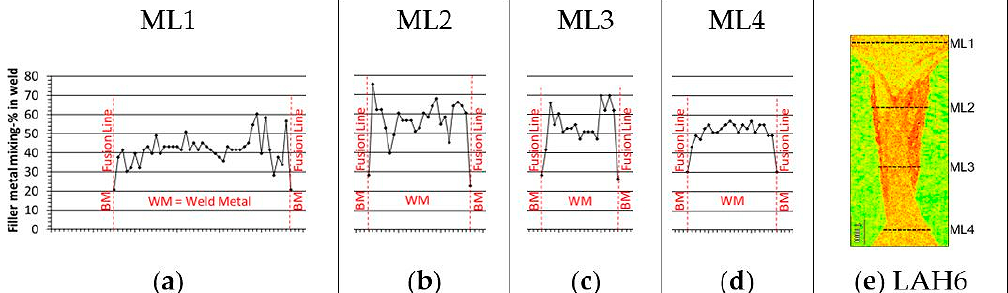
Figure 14. Filler metal mixing results from EDS stepwise characterization. ( a – d ) Filler metal mixing-% profiles of measurement lines 1–4 (ML1–ML4) from test weld LAH6 ( e ). In figures ( a – d ) one step between adjacent measurement points in the horizontal axis equals 100